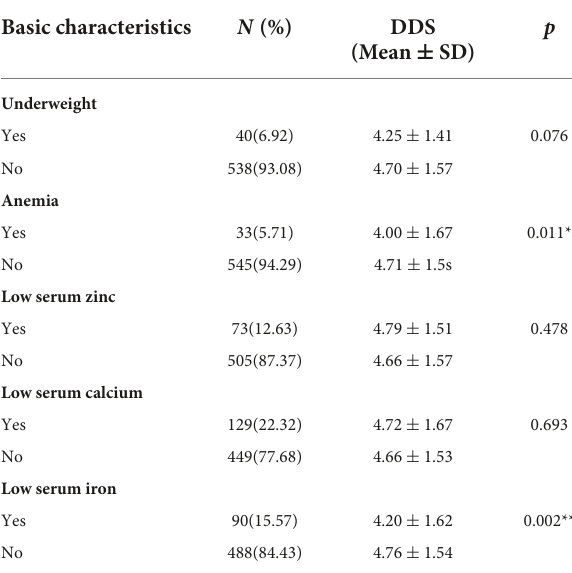
TABLE 1 The dietary diversity score (DDS) and participants’ basic characteristics ( n = 578).